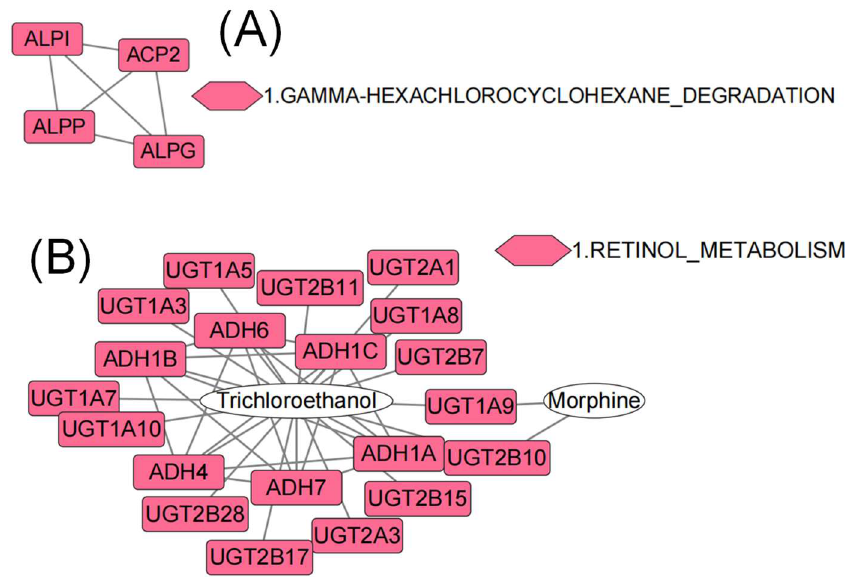
Figure 7. The most significant gene interactive network for the aged-combined group in male ( A ) and female ( B ) according to R spider enrichment of differential genes. The colored node is labeled by the human homologs of differential genes, where the same color represents the enrichment along the same pathway. Only overrepresented pathways are colored. The number preceding the pathway denotes the hierarchy order.